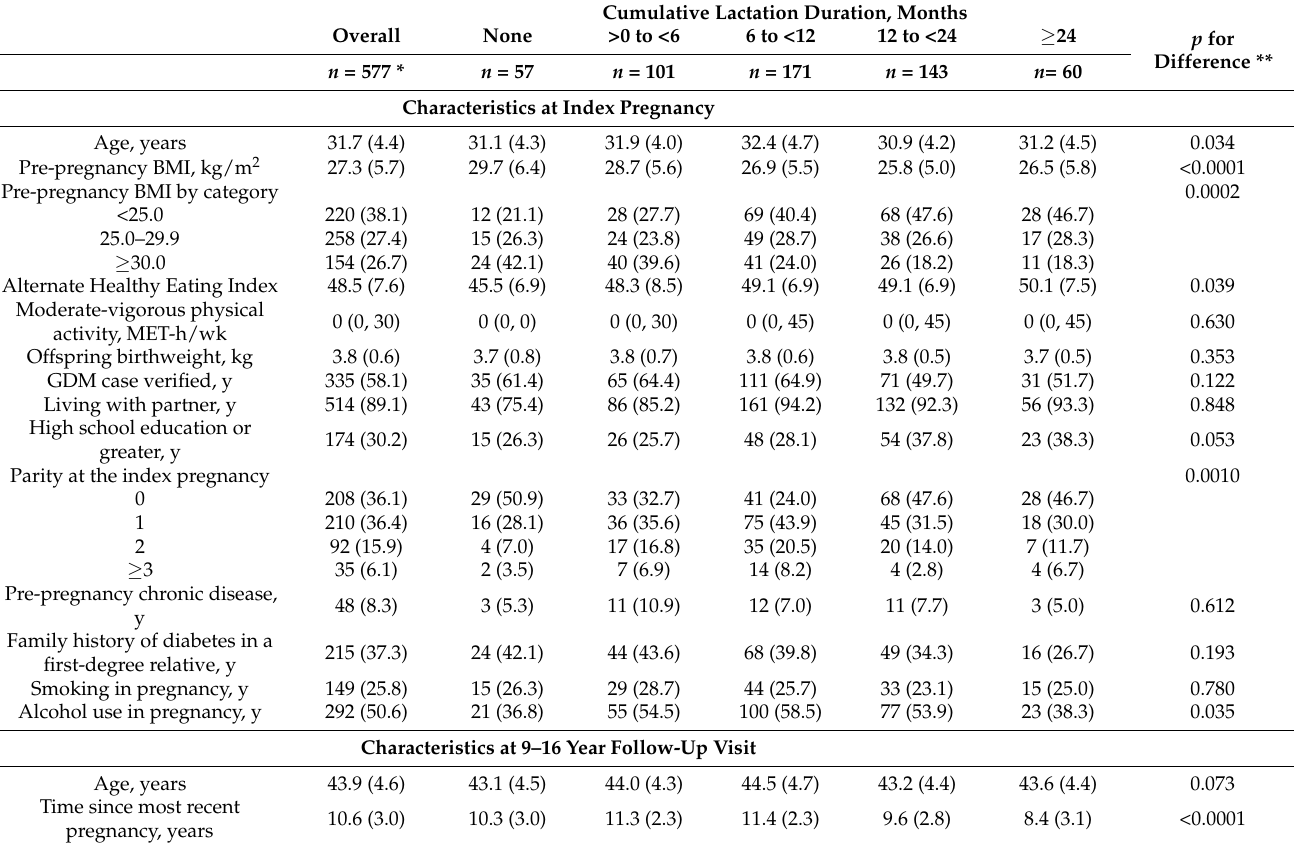
Table 1. Characteristics of women with past gestational diabetes mellitus enrolled in the Diabetes & Women’s Health Study, overall and stratified by cumulative duration of